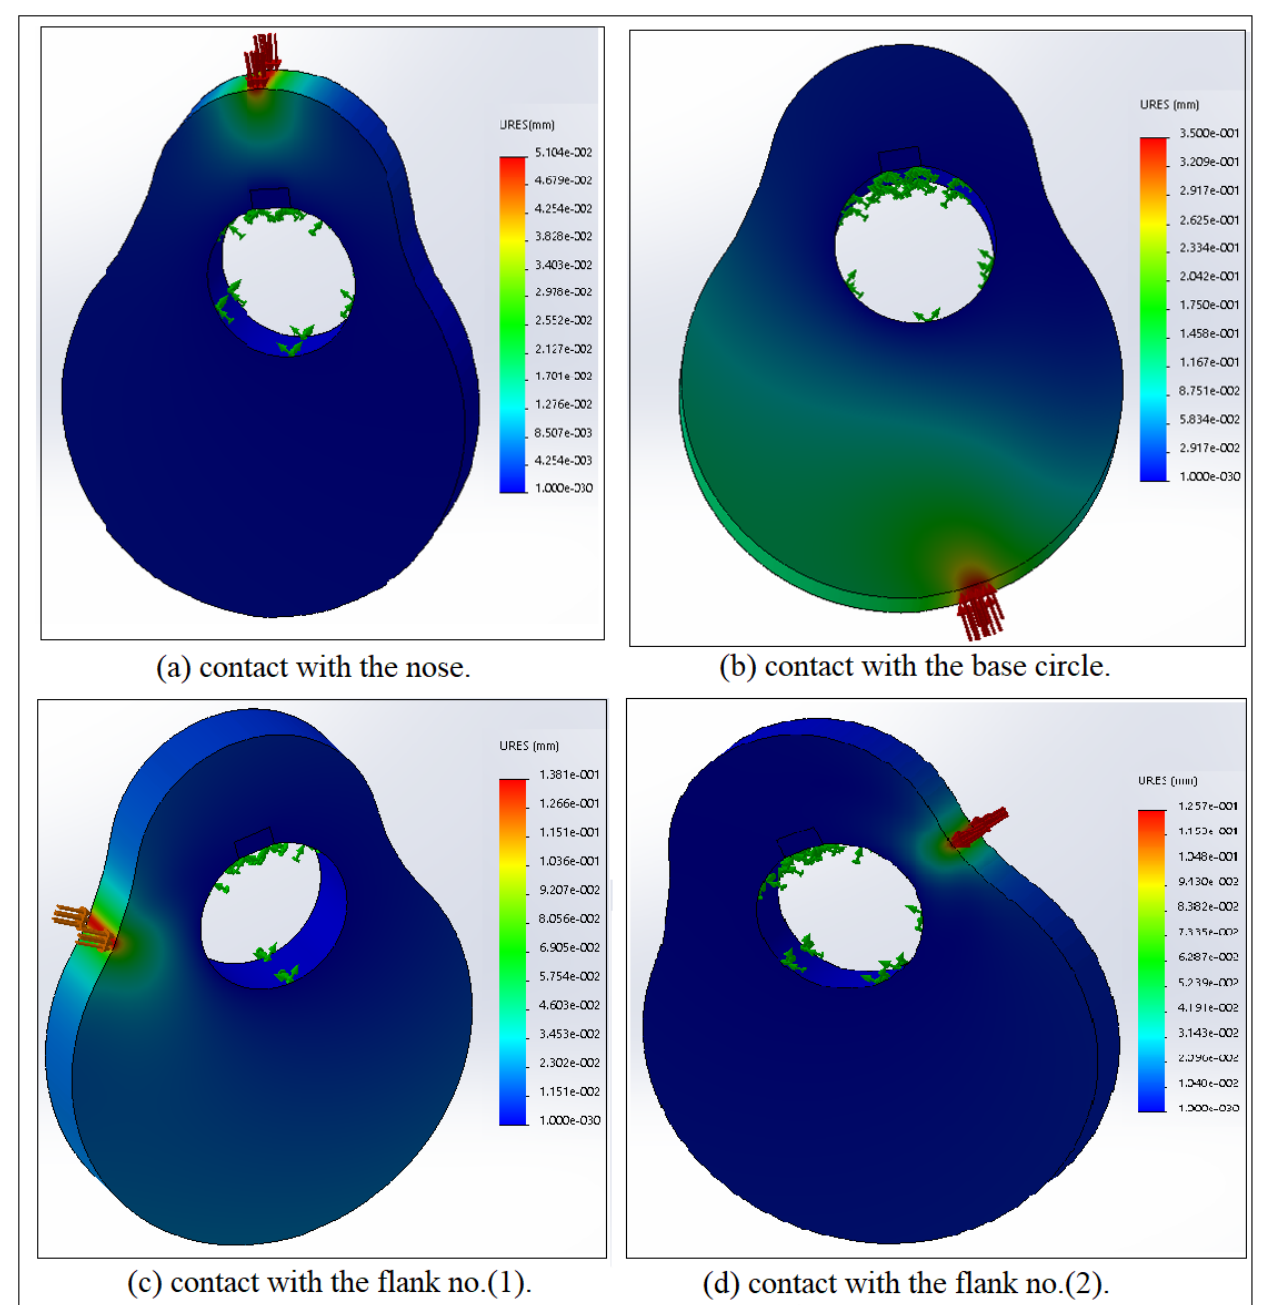
Figure 20. Bending deflection mapping contour for profile no.(1) at different contact locations.